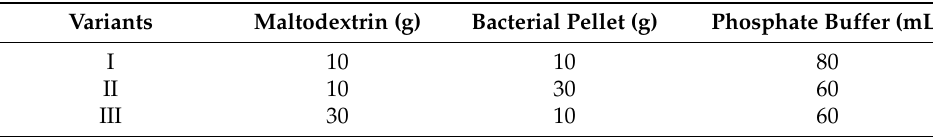
Table 1. Ratio of components in atomized